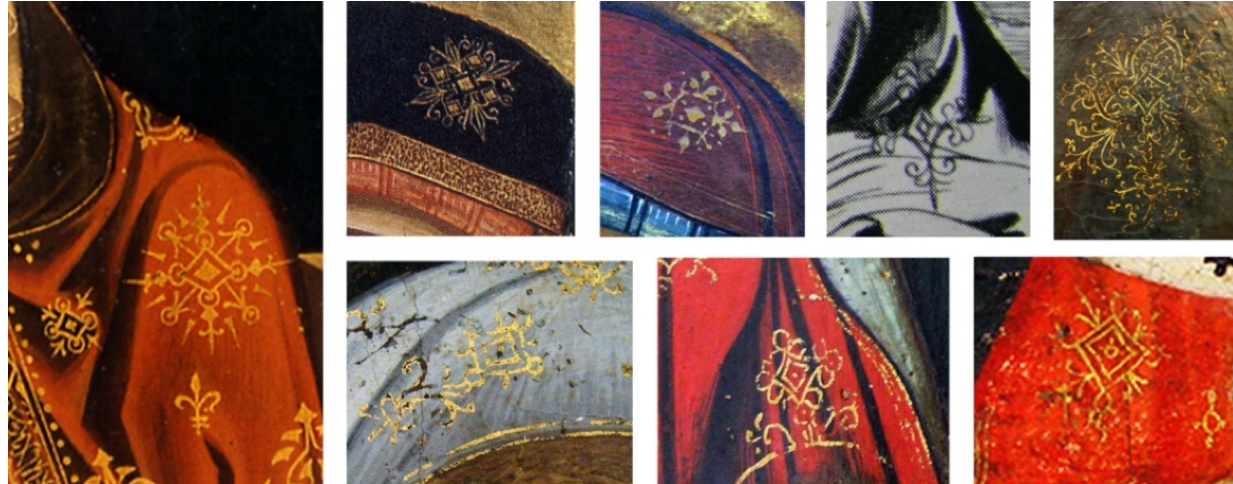
Figure 9. Angelos Bitzamanos. The Scottivoli altarpiece (detail), 1508. Vatican City, Apostolic Palace ( left ) © Musei Vaticani. Reproduced with permission; Angelos Bitzamanos (attr.). Madonna and Child (detail). Barletta, San Sepolcro; Angelos Bitzamanos (attr.). Madonna and Child (detail). Lecce, Museo Provinciale; Seroux d’Agincourt after Donatos Bitzamanos. Noli me tangere; Donatos Bitzamanos. Madonna and Child with Saints (detail), 1539. Bari, Pinacoteca Provinciale; Angelos Bitzamanos. Madonna and Child (details). Split, Arheološki Muzej; Angelos Bitzamanos. Saint Blaise (detail), 1518. Dubrovnik, Franjevački Samostan (from top left to bottom right ). Author’s photos; Figure created by author.